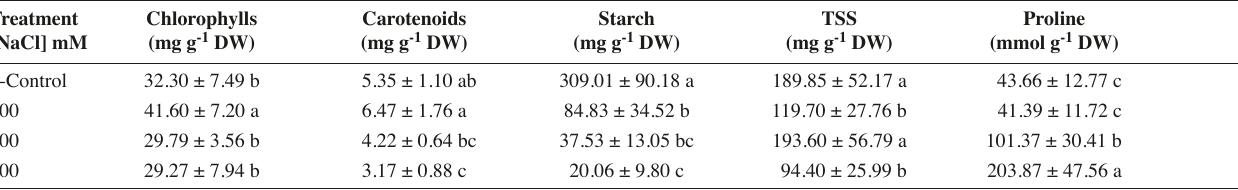
Tab. 3: Leaf photosynthetic pigment concentration and leaf concentration of starch, total soluble sugars (TSS) and proline in iceplant subjected to different salt conditions. Treatment